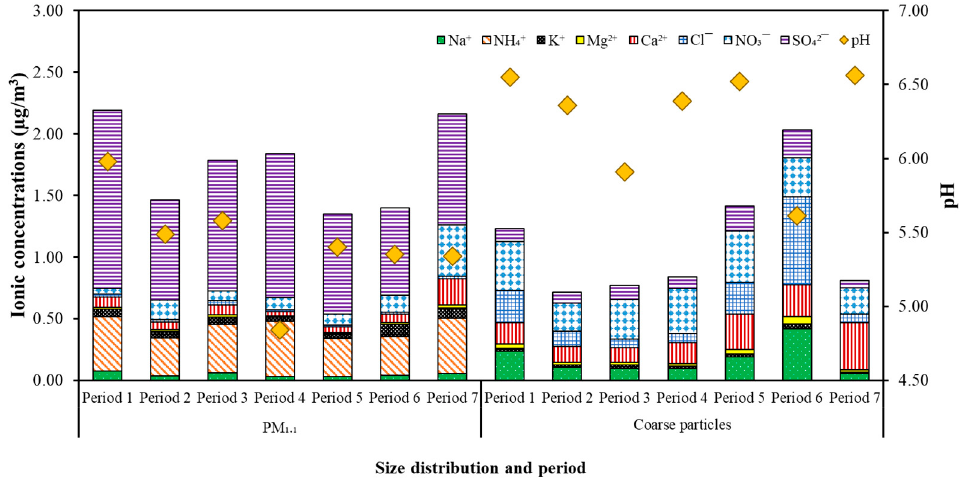
Figure 6. Distributions of water-soluble ionic contents and pH in PM 1.1 and coarse particles (>7.0 µm) during 7 sampling periods.